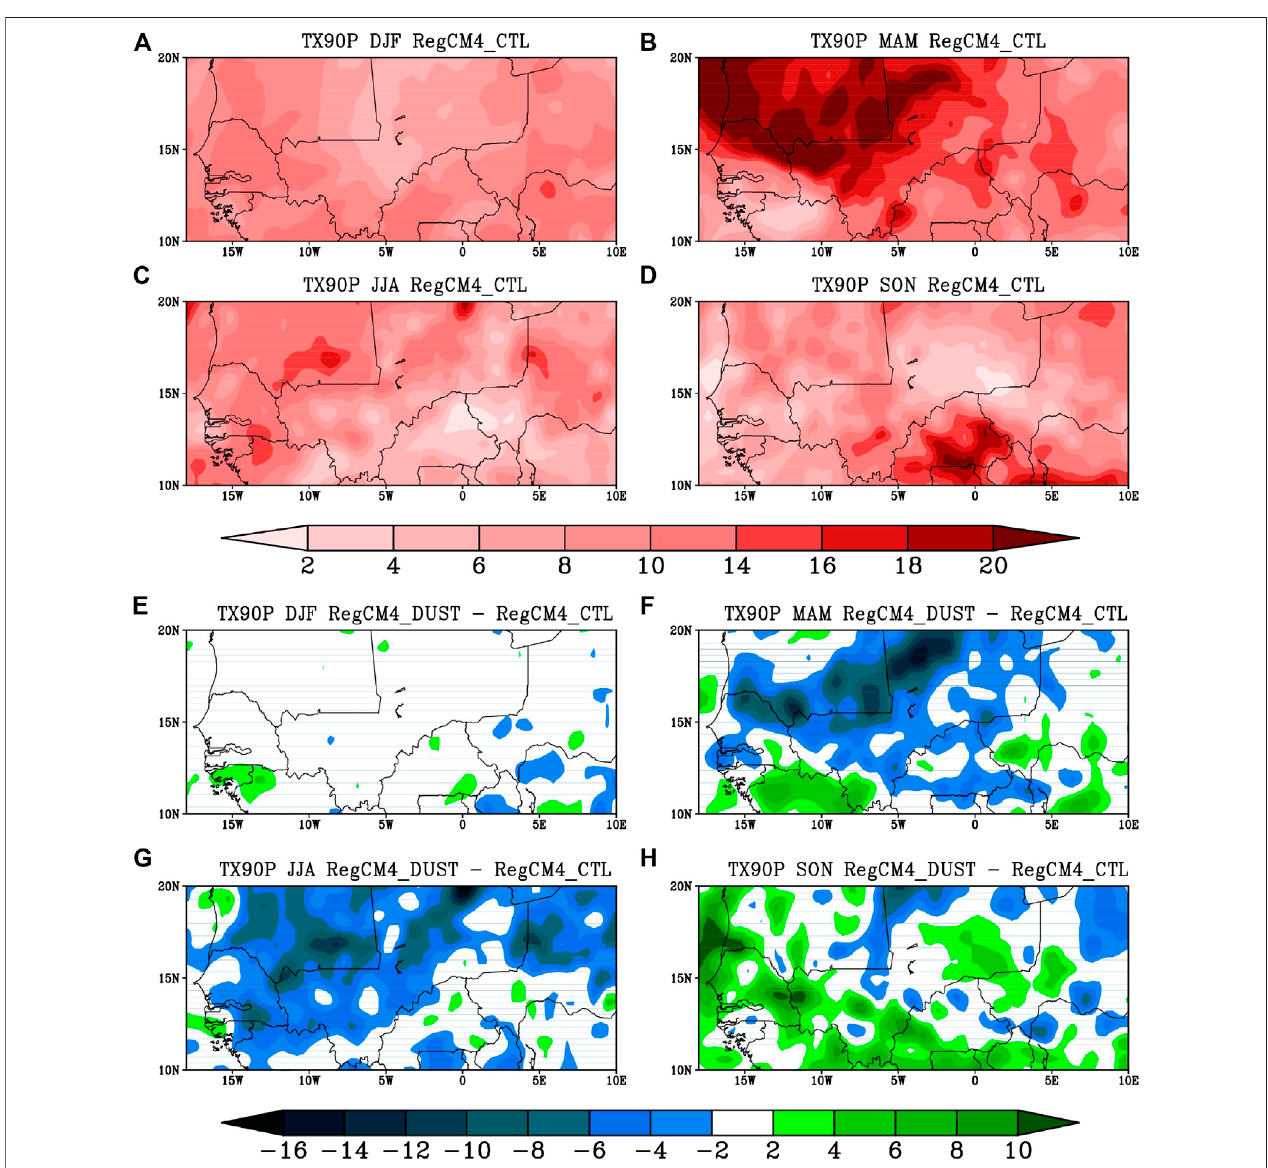
FIGURE 6| Seasonal variability of the percentage of very warm days (TX90P) averaged from 2001 to2010 over the Sahel: (top) RegCM4_CTL, (down) difference between RegCM4_DUST and RegCM4_CTL. The differences are signi fi cant at 95% level using the Student test.